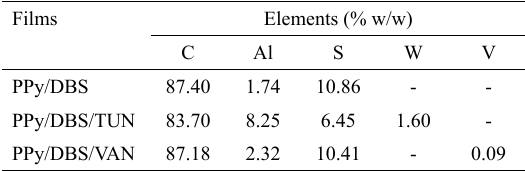
Table 1. EDS analysis for the PPy/DBS PPy/DBS/VAN and PPy/DBS/TUN electrodeposited on the AA 1100 substrate